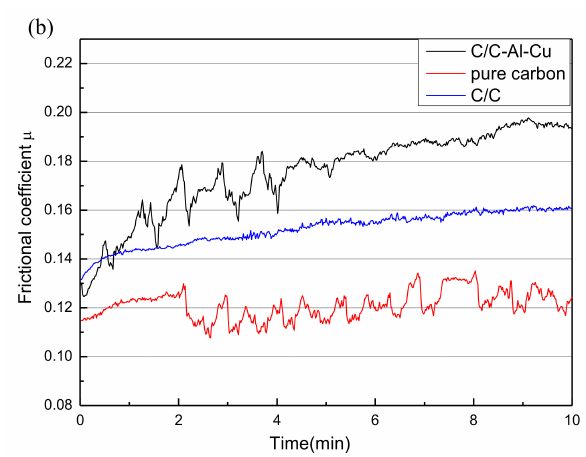
Figure 6. Friction coefficient for different samples. ( a ) Friction coefficient and wear rate; and ( b ) friction coefficient curve.